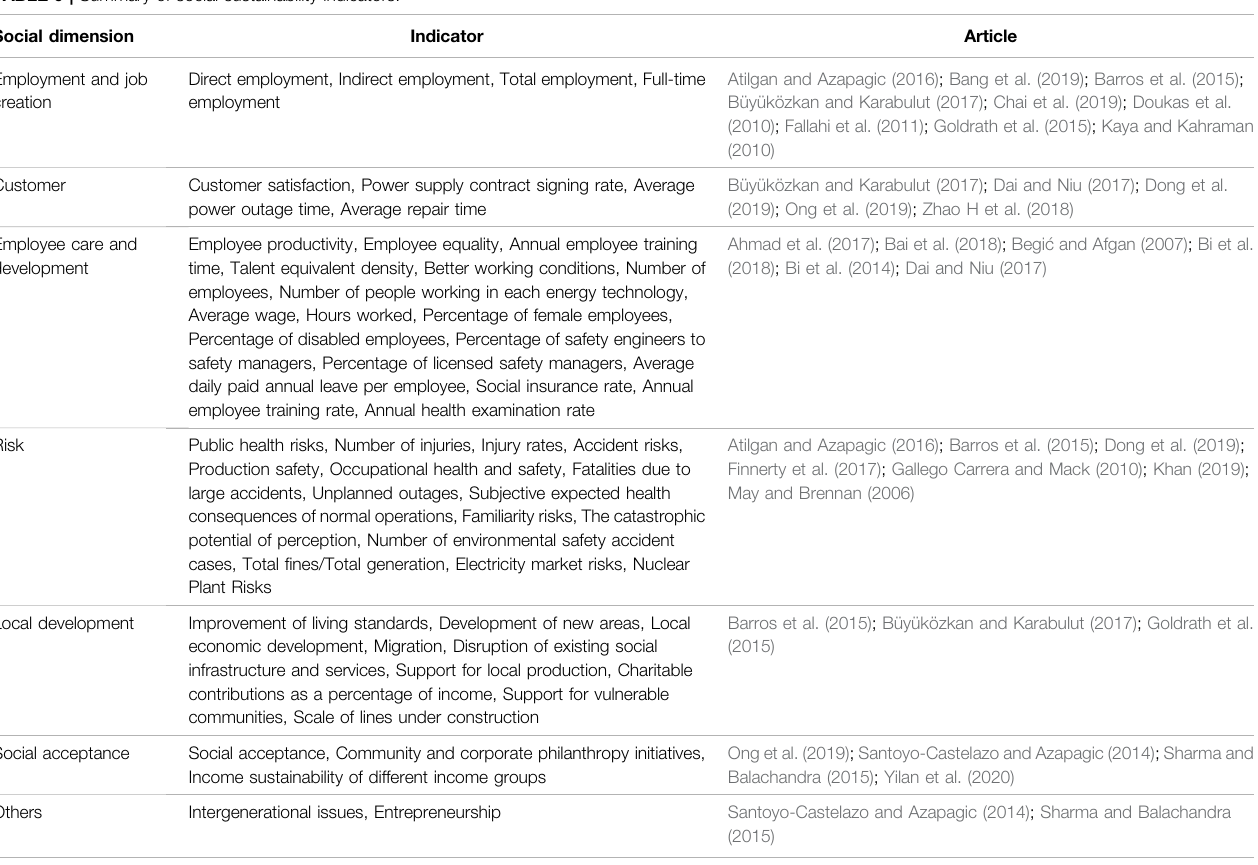
TABLE 9 | Summary of social sustainability indicators. Social dimension Indicator